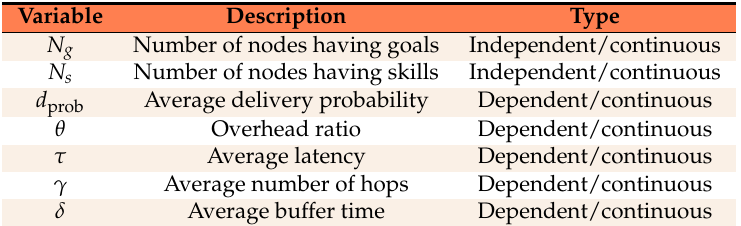
Figure 13. Average buffer time ( δ ) vs. frequency of messages generation ( ω ): mall. Table 3. Criteria and variables used in the multivariate